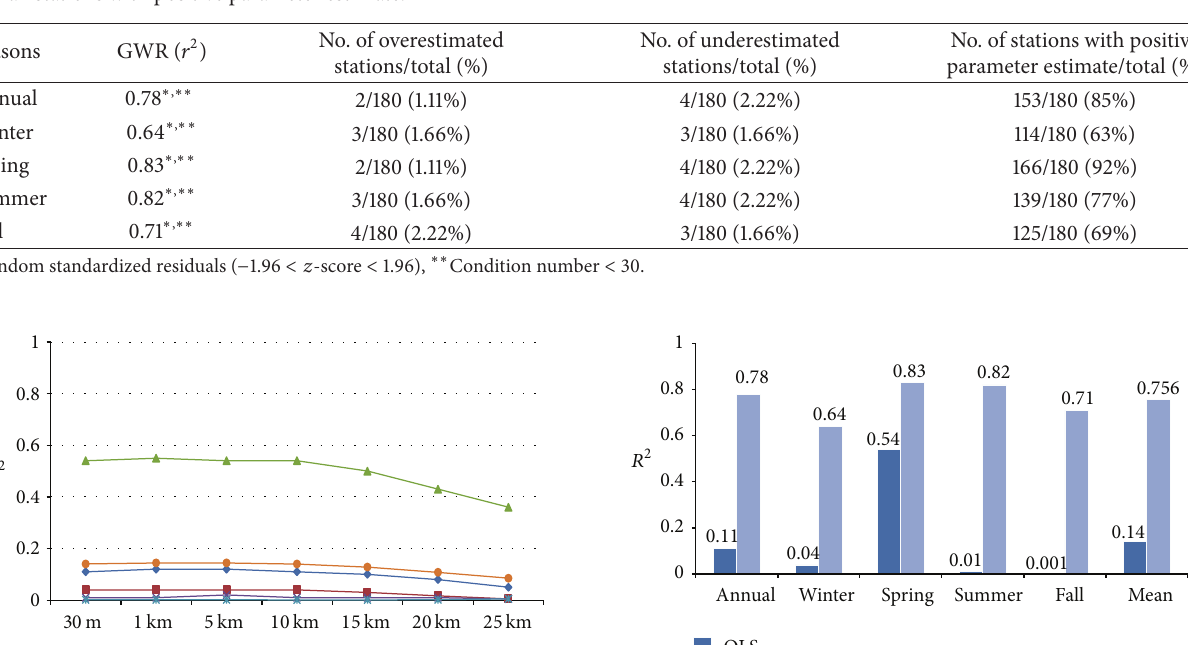
Table 2: Coefficient of determination ( 𝑟 2 ) derived by GWR, percentage of over- and under estimated rainfall stations and percentage of rainfall stations with positive parameter estimate.